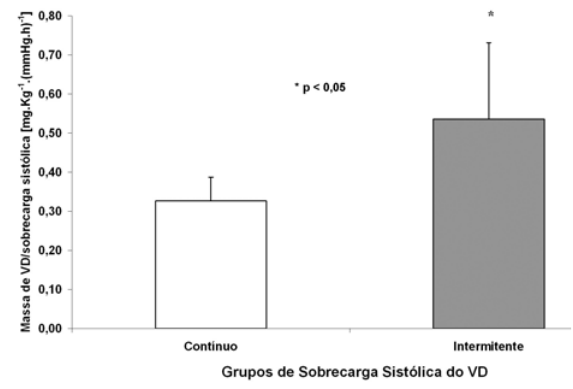
Fig. 5 - Índice de massa do Ventrículo Direito (VD). Massa do VD indexada pela área de sobrecarga sistólica dos grupos contínuo e intermitente.